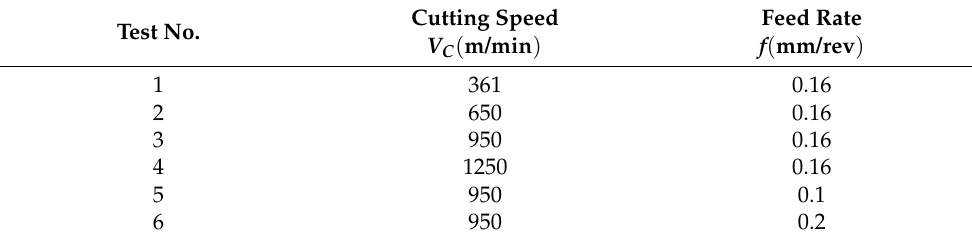
Table 1. Cutting conditions for tool geometry including r β = 0.02 mm, γ o = 17.5 ◦ , and α o = 7 ◦ . Test No.